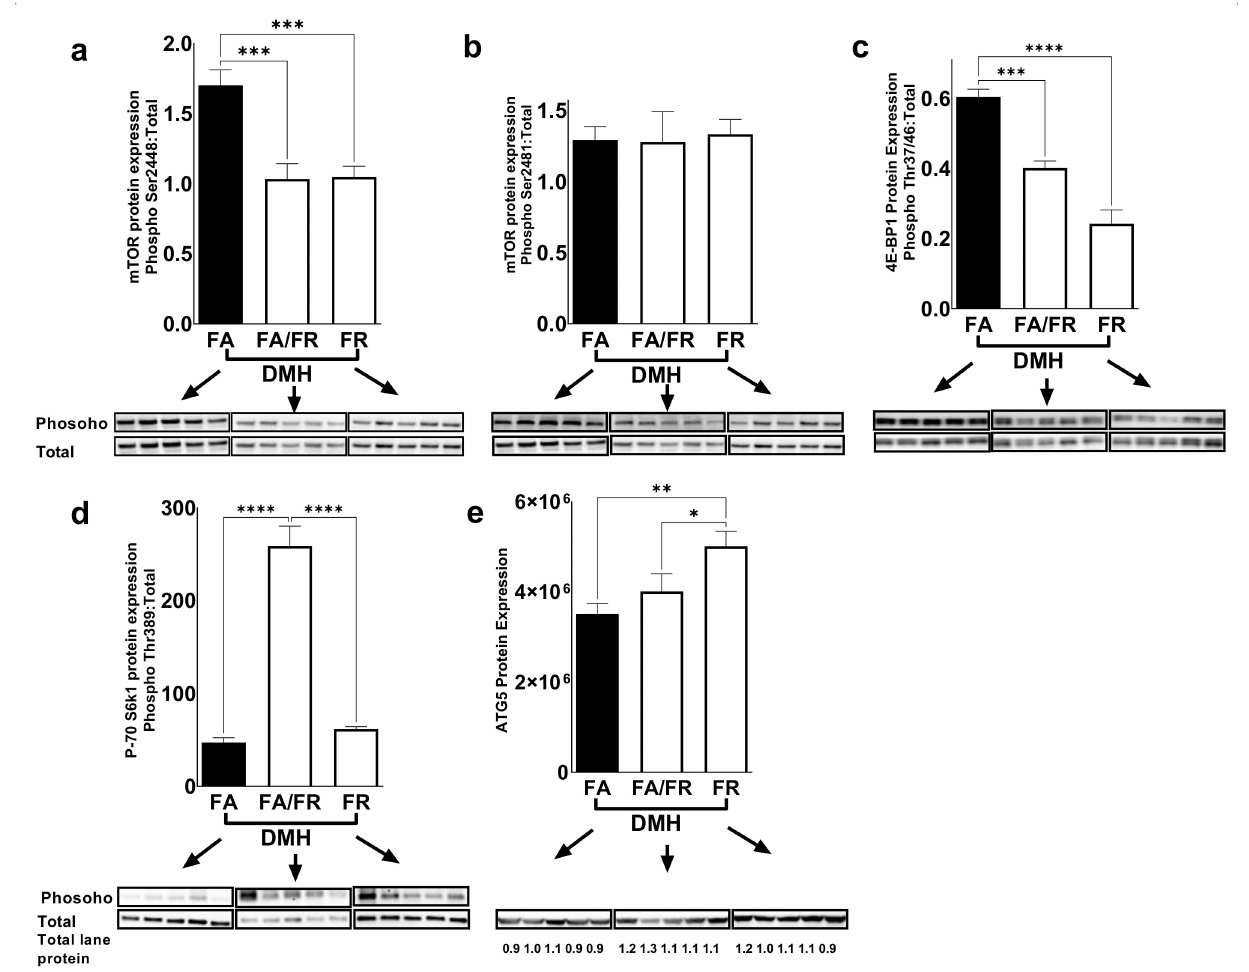
Figure 2. Folate restriction downregulates the mTOR signaling pathway in the liver of DMH-treated mice. Western blot images and quantification of ( a , b ) mTOR phosphorylation at Ser2448 and Ser2481 residues, and ( c , d ) phosphorylation of downstream targets of mTOR (4EBP1 (Thr37/46)) and S6K1 (Thr389), and ( e ) expression of the autophagy related protein ATG5. FA = folate adequate diet, FA/FR = folate adequate diet followed by initiation of folate-restricted diet one week prior to DMH injections, FR = folate-restricted diet. Phosphorylated protein was normalized to the respective total protein unless indicated and expressed as ratio. Bands were normalized to total lane